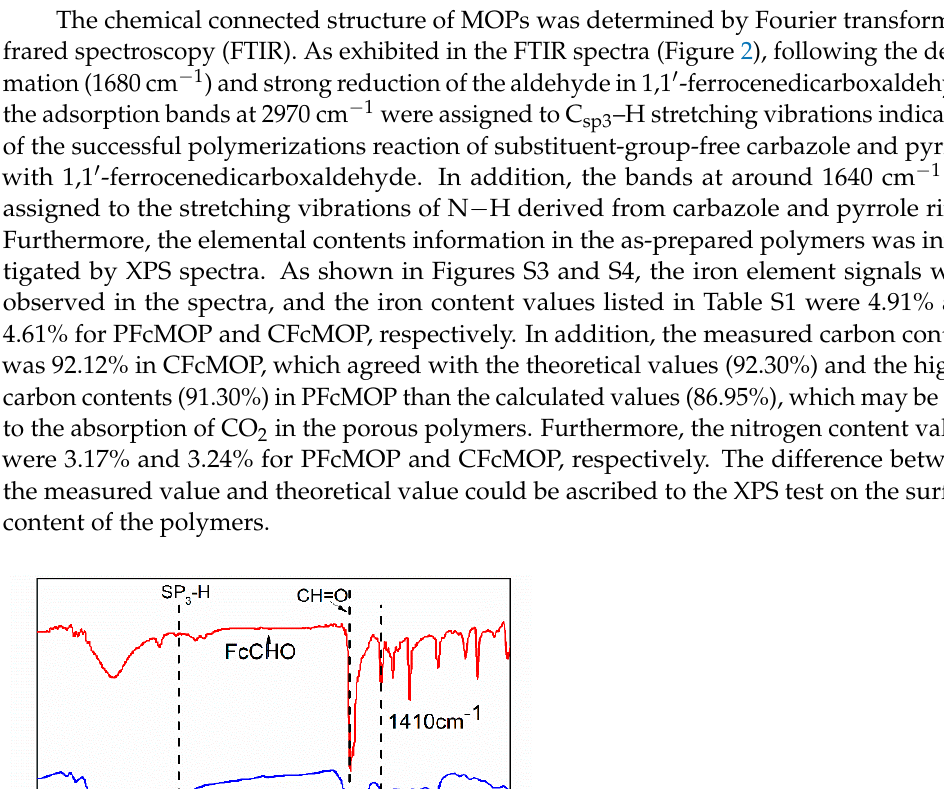
Figure 2. FTIR spectra of 1,1 ′ -ferrocenedicarboxaldehyde and the two ferrocenyl microporous polymers networks.